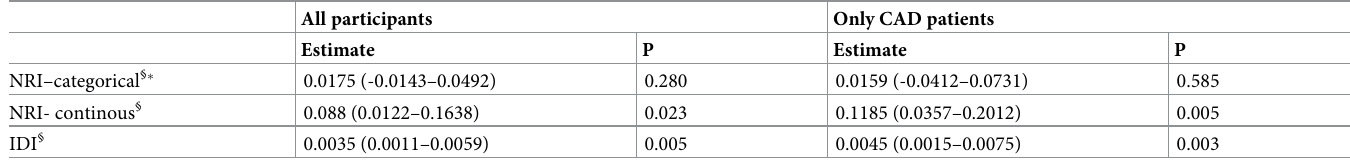
Table 5. Impact of INR on mortality: Net-reclassification-index and